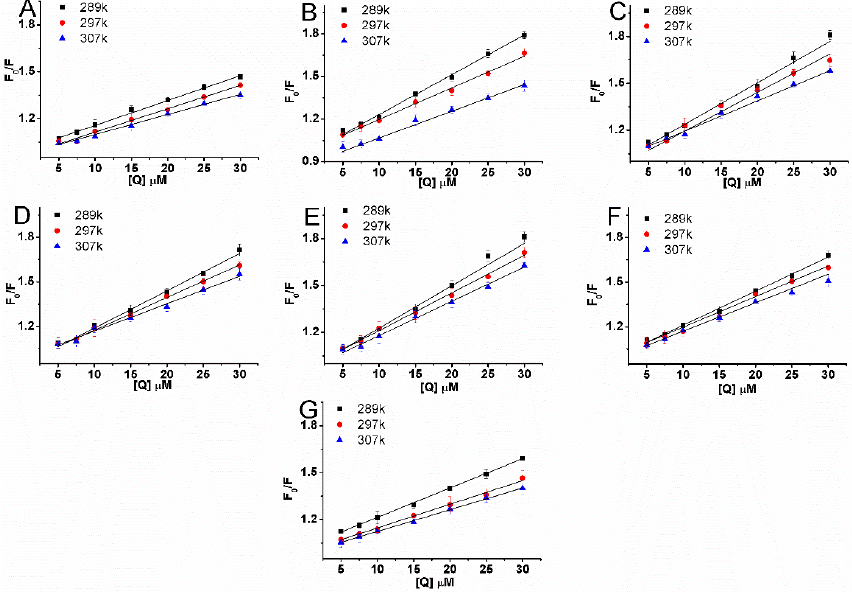
Figure 4. Stern–Volmer plots for BSA (5 µ M) quenched by compounds 1 ( A ), 2 ( B ), 3 ( C ), 4 ( D ), 5 ( E ), 6 ( F ), and 7 ( G ) at different temperatures in 0.05 mol L − 1 Tris-HCl, pH 7.4. The concentrations of compounds varied from 0 to 30 µ M.